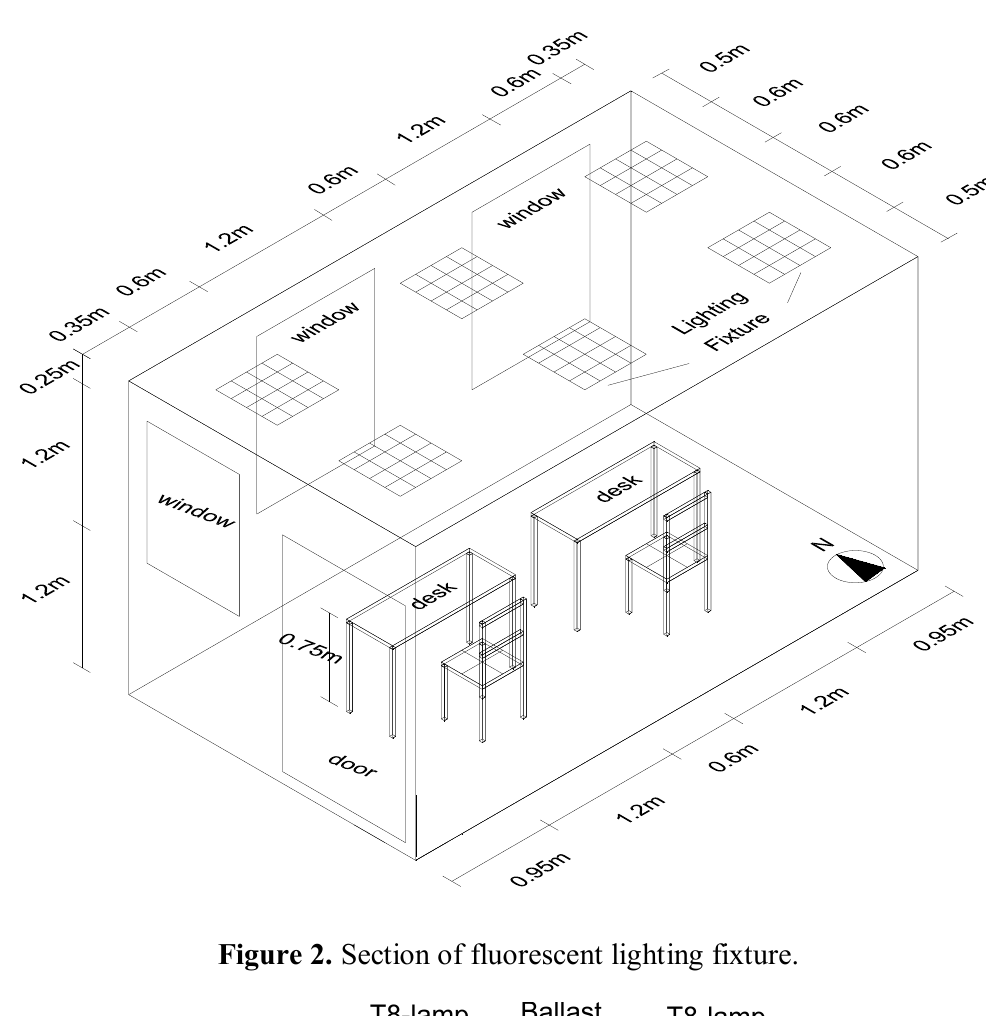
Figure 1. Detailed view of full-scale mock-up model space.